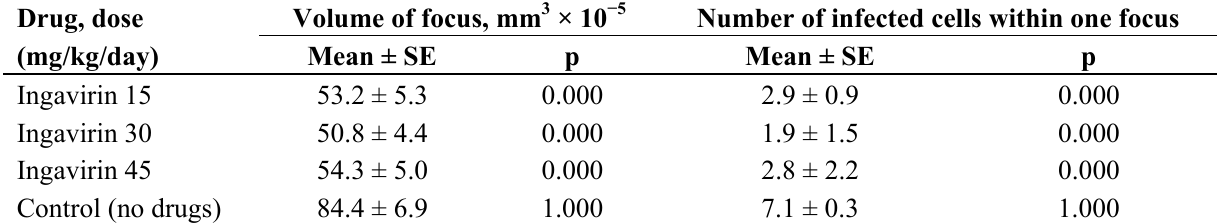
Table 4. Effect of Ingavirin on the course of AdV-induced hepatitis in newborn Syrian